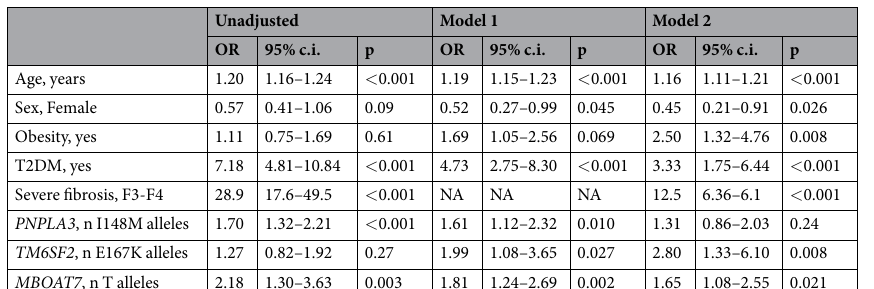
Table 3. Independent predictors of HCC in 765 Italian patients with NAFLD. OR: odds ratio of HCC, 95% c.i.: 95% confidence interval; T2DM: type 2 diabetes mellitus; n: number of at risk alleles. Comparisons were performed by logistic regression setting HCC as dependent variable, and the association of genetic variants was analyzed assuming additive models. Model 1: adjusted for age, sex, obesity, and T2DM; Model 2: further adjusted for presence of advanced fibrosis; NA: not